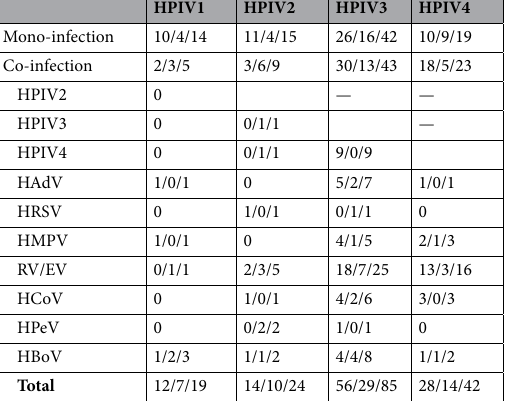
Table 1. Detection of HPIV and other viral pathogens among the outpatient and inpatient cohorts. Number of positives for outpatients/inpatients/total. No HPIV-positive samples tested positive for influenza A or B virus. HPIV, human parainfluenza virus; HAdV, human adenovirus; HRSV, human respiratory syncytial virus; HMPV, human metapneumovirus; RV, rhinovirus; EV, enterovirus; HCoV, human coronavirus; HPeV, human parechovirus; HBoV, human